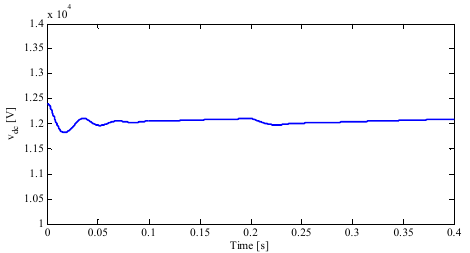
Figure 12. DC ‐ link voltage of MMC with parameter variations.